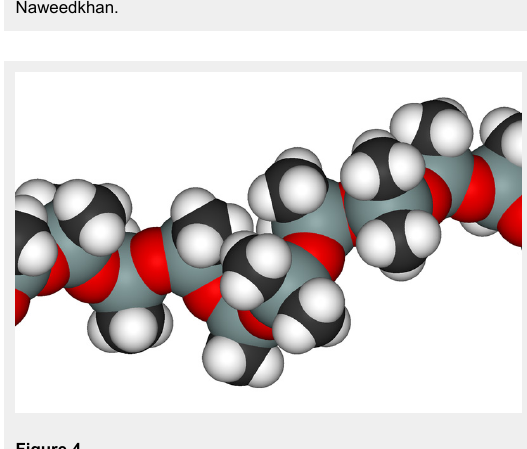
Flow chart of the process – starting with sand – for making siloxane-based materials, including silicone rubber and silicone gel used in breast implants. Source: Wikimedia Commons, © Naweedkhan.